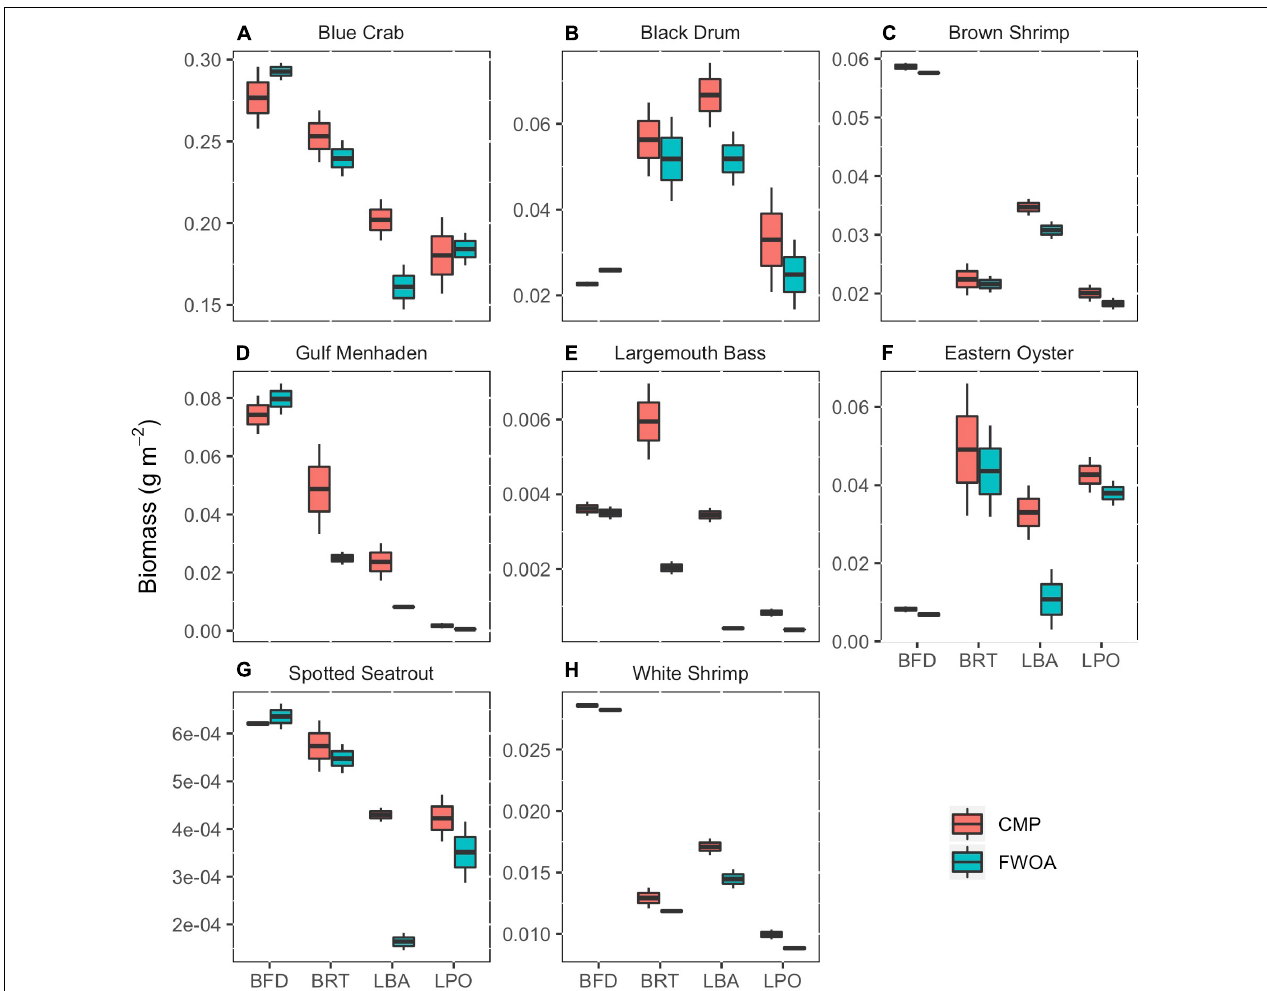
FIGURE 5 | The biomass in simulation year 50 of eight species of economic interest in four different basins (BFD, Birdsfoot Delta; BRT, Breton Sound; LBA, Lower Barataria; LPO, Lower Pontchartrain) in coastal Louisiana after 50 years of Coastal Master Plan (CMP) implementation compared to a future without action (FWOA). The boxes in the box plots reflect the model output of two different SLR scenario simulations. (A) Blue Crab, (B) Black Drum, (C) Brown Shrimp, (D) Gulf Menhaden, (E) Largemouth Bass, (F) Eastern Oyster, (G) Spotted Seatrout, (H) White